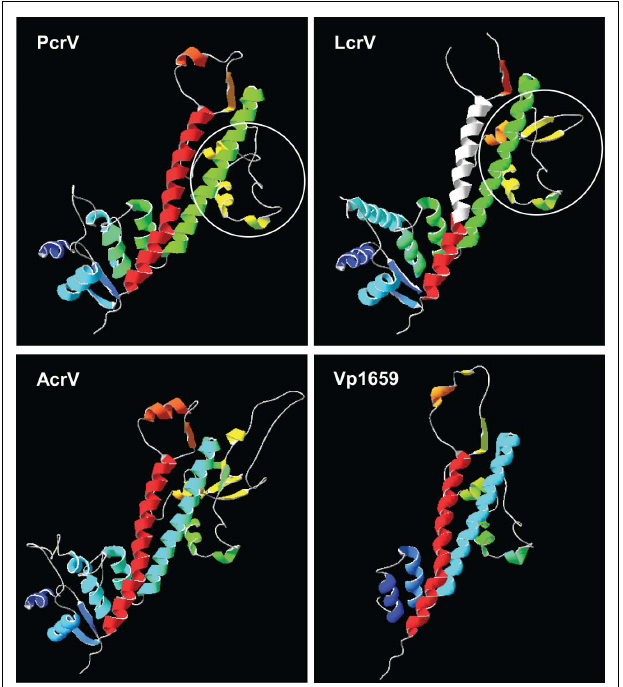
FIGURE 2 | Structural models of theV-tip protein family. V-tip proteins are modeled using LcrV (PBD: 1r6f chain A) as a template (Swiss Model server, http://www.expasy.org).The models indicate the conserved coiled-coil structure of two α -helices flanked by globular domains at each end. One of the globular domains contains protective-epitope regions identified in PcrV and LcrV (a while circle; Frank et al., 2002; Quenee et al., 2010).The immunomodulatory region of LcrV (residues 271 to 300) is located in one of the coiled-coil helices with a connected coil structure (indicated in white; Overheim et al., 2005).This region is deleted in the rV10 subunit vaccine, by which the immunomodulatory responses are eliminated (Overheim et al.,